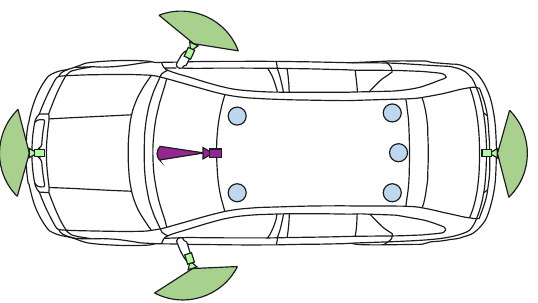
Figure 3. Sensor payload of test vehicle: 360 ◦ LiDARs in blue, area-view system with fish-eye RGB cameras in green, narrow FoV camera in